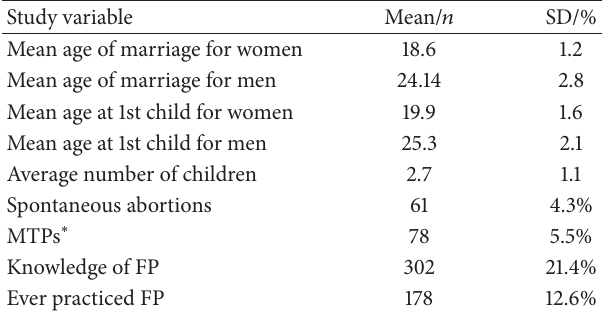
Table 2: Family planning (FP) status among eligible couples in the area before the implementation of family centered approach ( 𝑛 = 1409